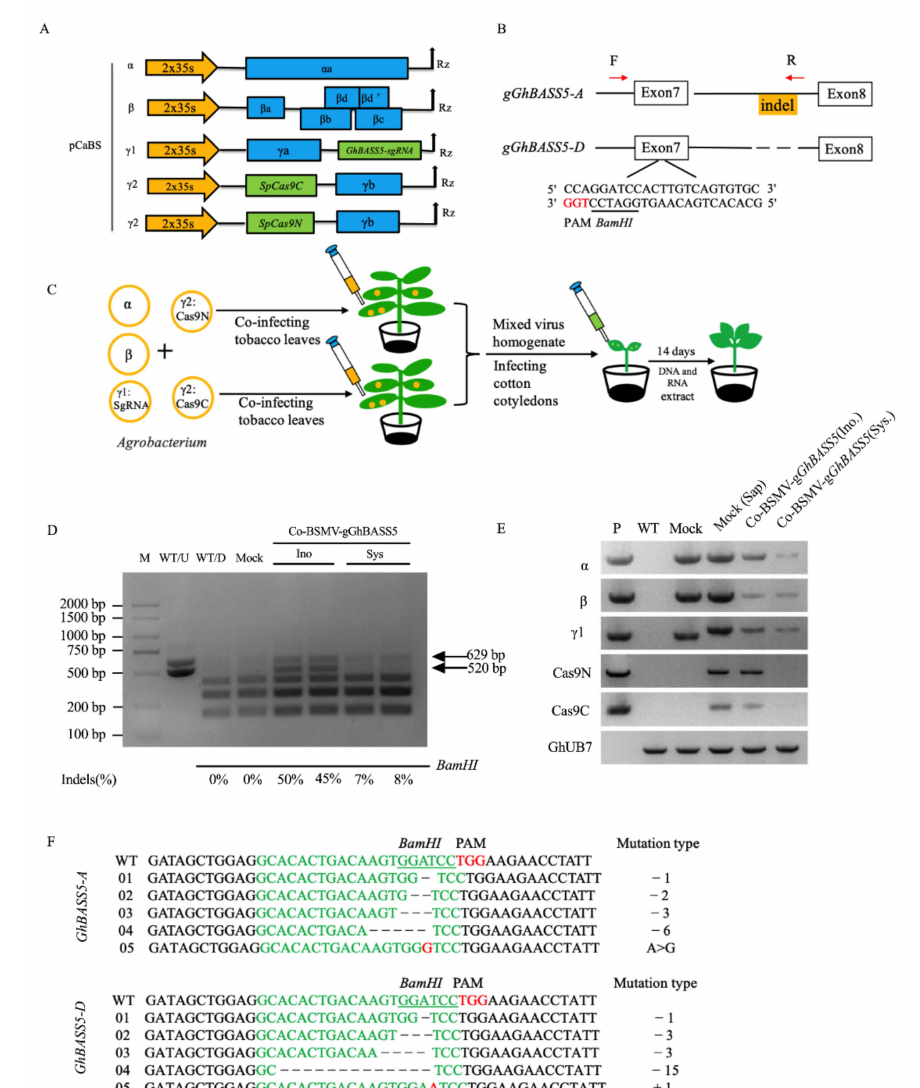
Figure 6. DNA-free gene editing using BSMV-delivered CRISPR/Cas9 system in cotton. ( A ) Schematic representation of the BSMV recombinant constructs applied to the co-delivery of split-Cas9 proteins; ( B ) the gRNA sequences of GhBASS5 . F and R indicate the positions of primers for CAPS analysis; ( C ) workflow of the BSMV-mediated gene editing system in cotton; ( D ) analysis of the gene editing of GhBASS5 by CAPS. WT/U and WT/D indicated the undigested bands and digested bands. Mock is the negative control (empty vector). Ino: inoculated leaves; Sys: system leaves (the true leaves); ( E ). expression of each component of recombinant BSMV vectors in inoculated leaves; ( F ). GhBASS5 gene mutation types analyzed by